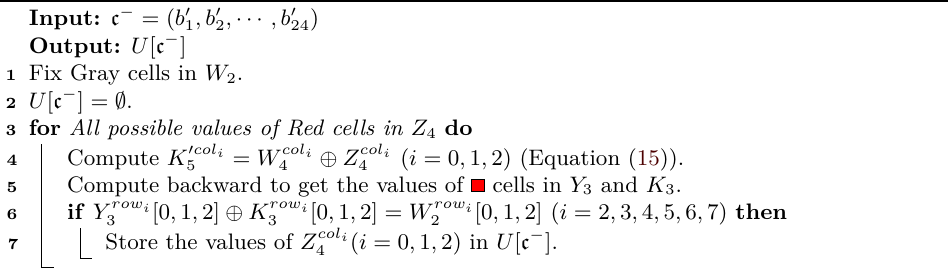
Algorithm 6: Compute the solution space of Red neutral cells in Figure